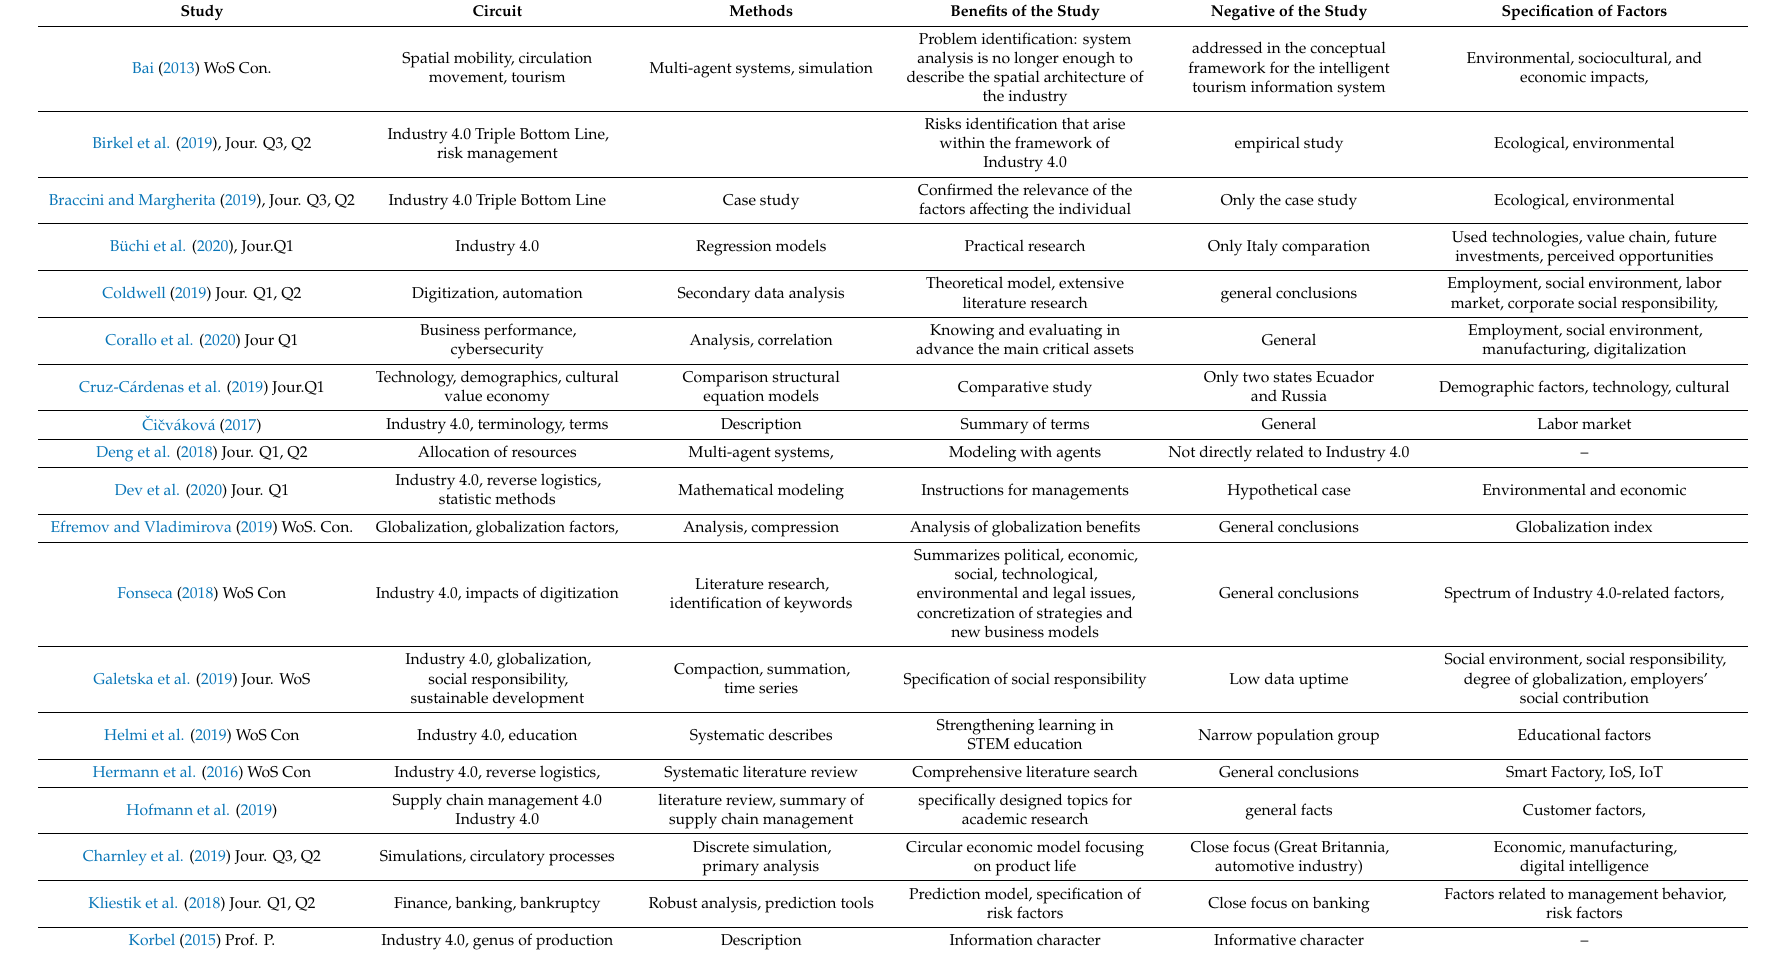
Table 2. Summary—literature